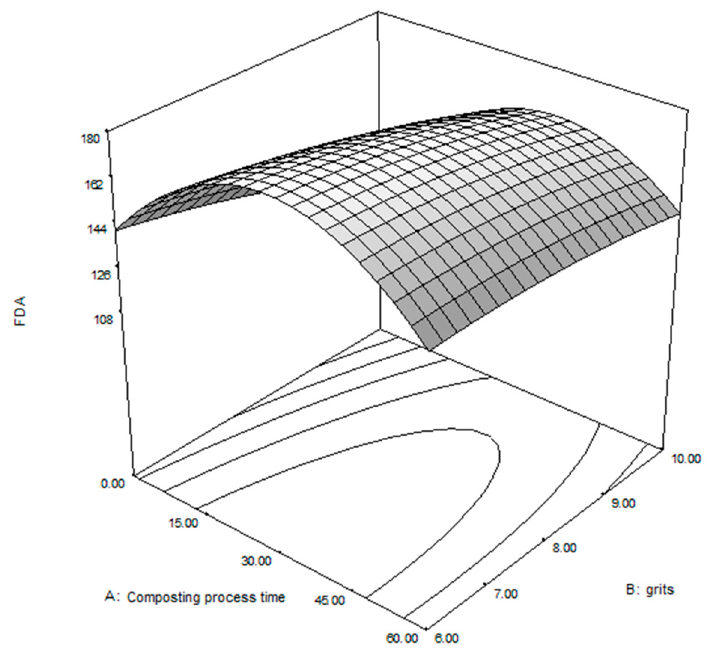
Figure 7. Fluorescein diacetate hydrolysis during the composting process for the mixtures is described in Table 2.